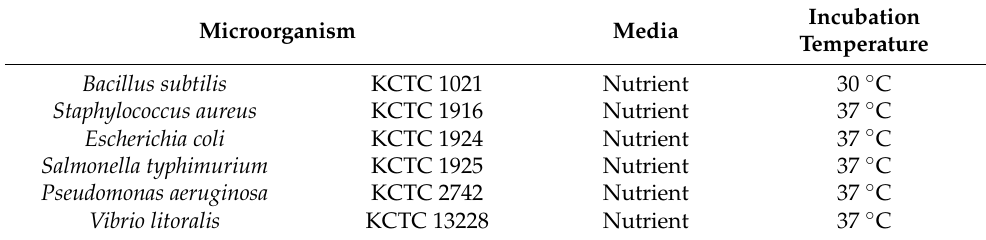
Table 4. List of microorganism strains and growth conditions used in antimicrobial